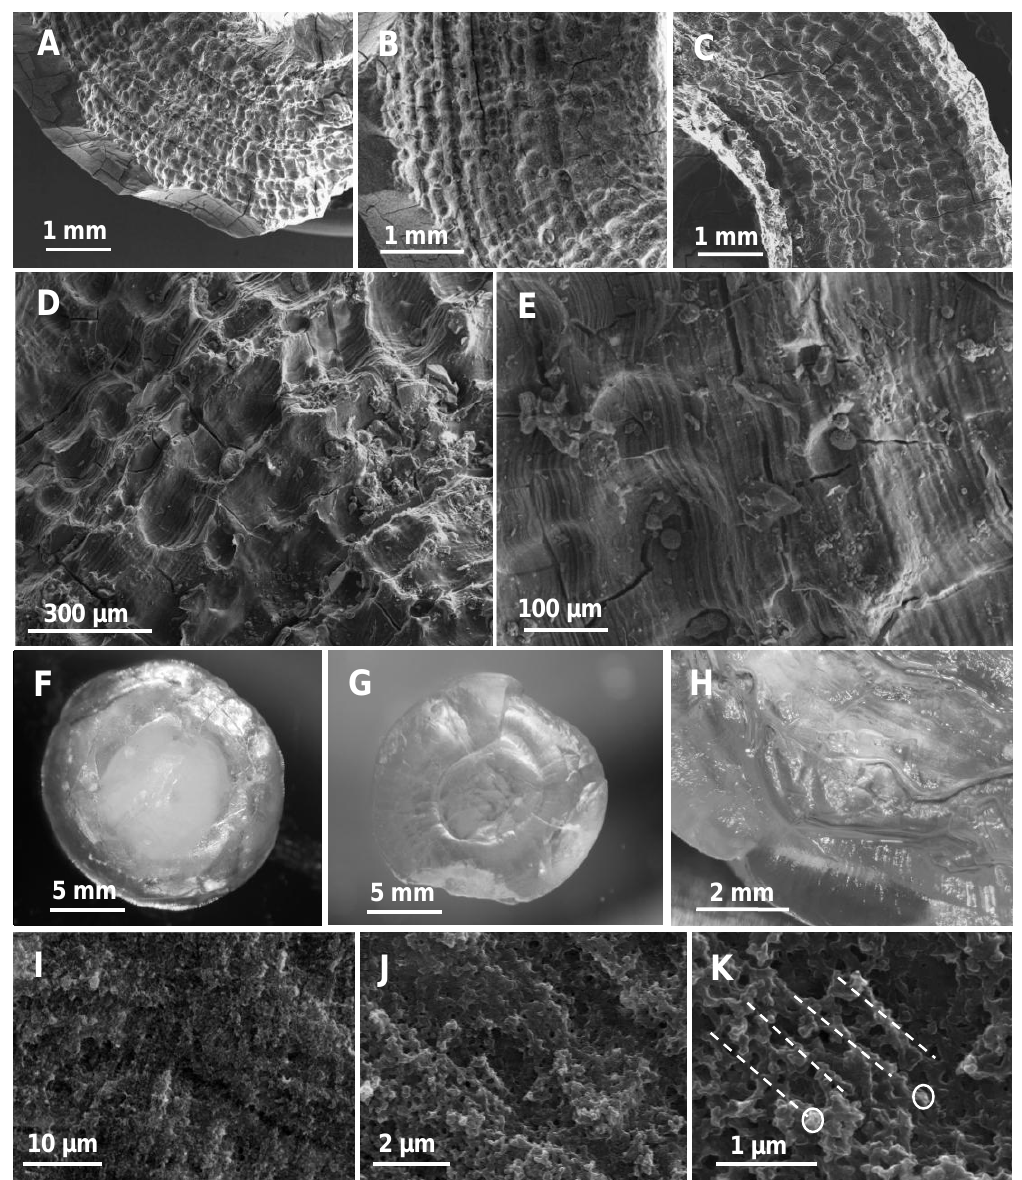
Figure 4. A–E: SEM observations of the external aspect of a Cherax gastrolith in postmolt after a beginning of natural digestion in the stomach (different magnifications). A layered pocket-like structure is observed. F–H : Sponge-like aspect of a Cherax gastrolith after a slow decalcification by 2.5% acetic acid (Light microscopy). F: after two days treatment, the center of the gastrolith (chalky) is not completely decalcified, G: Completely decalcified gastrolith after one week treatment (translucent aspect). H: Cross-section of a fully decalcified gastrolith. I–K: Internal aspect observed after fracture by SEM (three magnifications of the same sample are shown). The layered aspect is visible; each layer is formed by alignments (dashed lines) of dense aggregated spherical nanoparticles (circles).